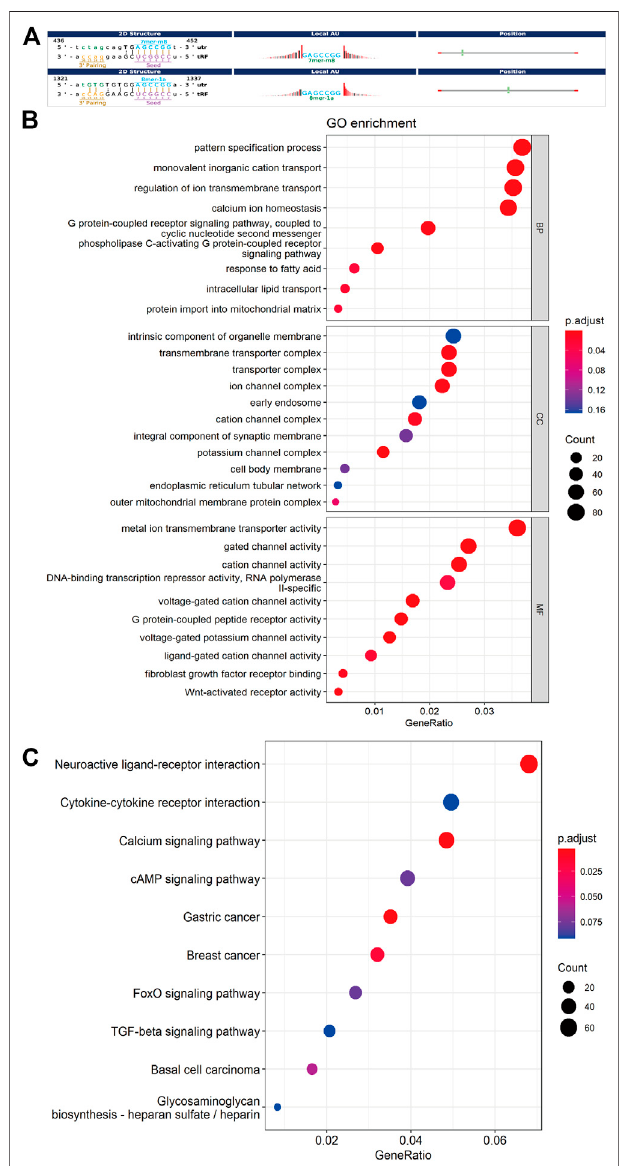
FIGURE 4 | Bioinformatic prediction and functional enrichment analysis of differentially expressed tsRNAs between the two groups. (A) The 2D structure of the interaction between tsRNA and predicted genes, demonstrating the speci fi c location of the binding site on the 3 ′ UTR (mRNA) or the full length of a particular sequence. (B) GO enrichment analysis for the 14 differentially expressed tsRNAs. (C) KEGG pathway analysis for the 14 differentially expressed tsRNAs. GO, Gene ontology; KEGG, Kyoto Encyclopedia of Genes and Genomes database.